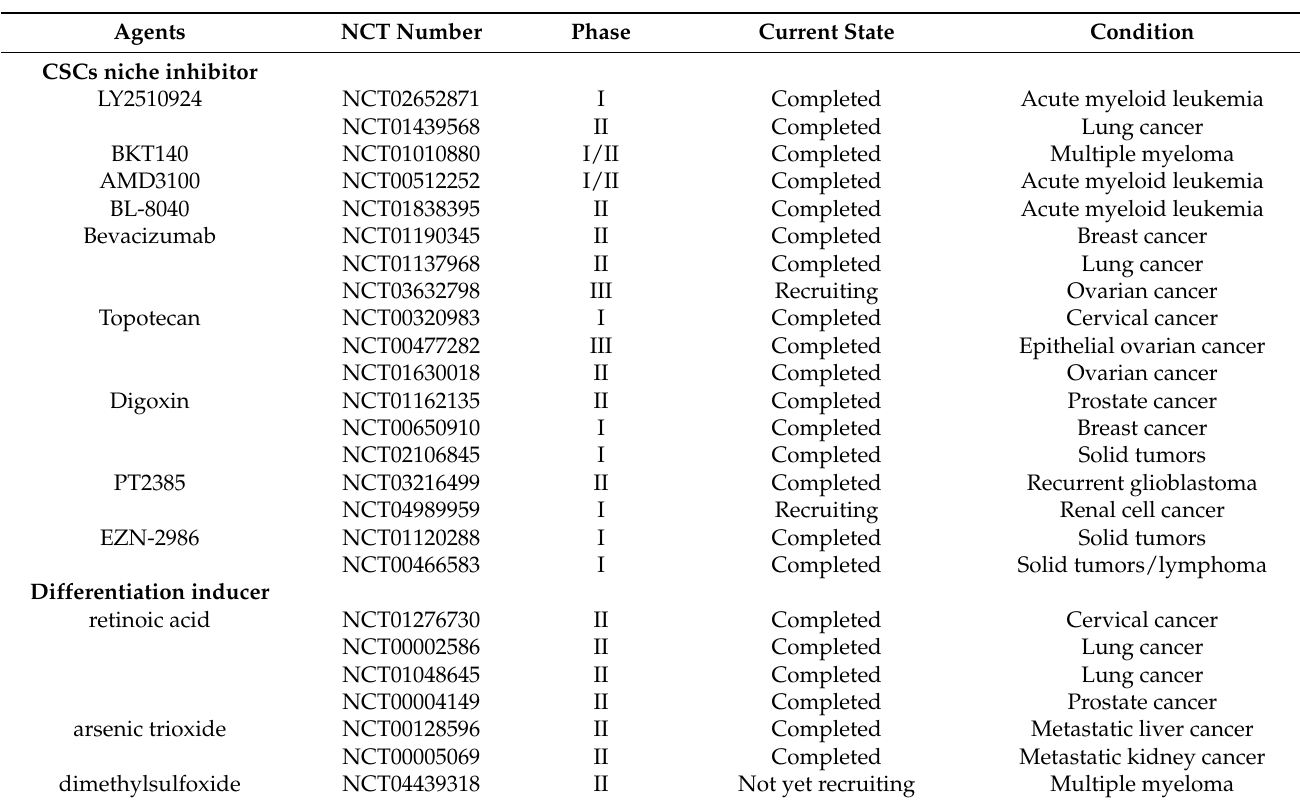
Table 5. Some agents targeting CSC niches and inducing differentiation which have been evaluated in clinical trials.